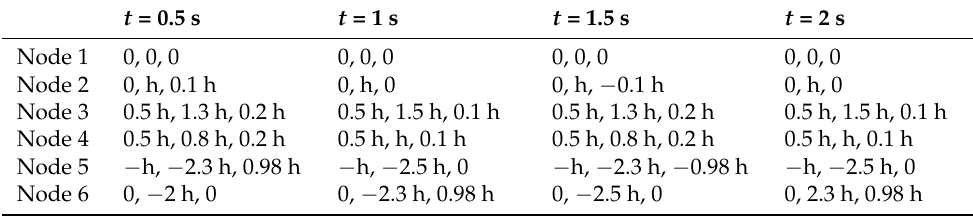
Table 5. Changes in node coordinates during human